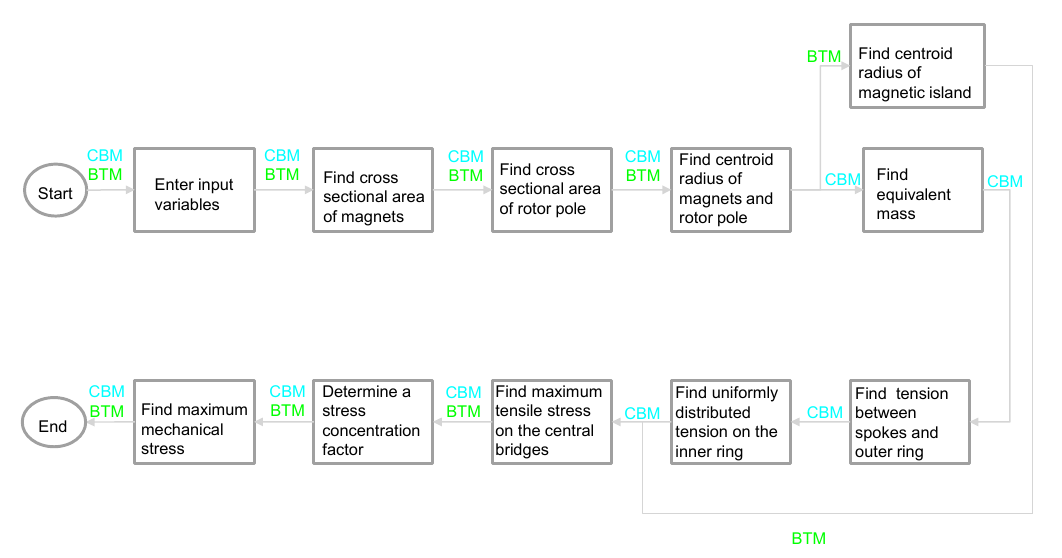
Figure 3. Methodology flow diagram of ERM1 to ERM5, CFM and BTM and general differences in the approaches.